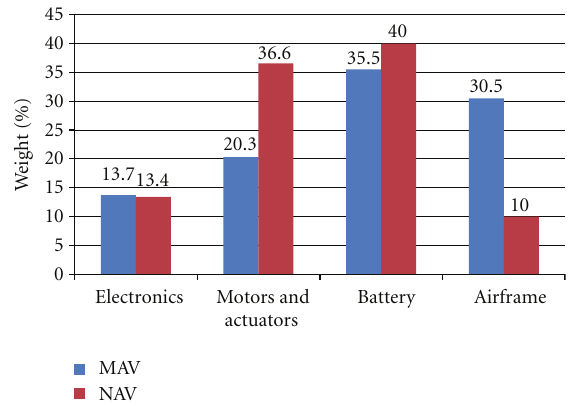
Figure 7: AVS weight budget allocation in percentage with respect to the total weigh calculated for a 197 g MAV and 15 g NAV.